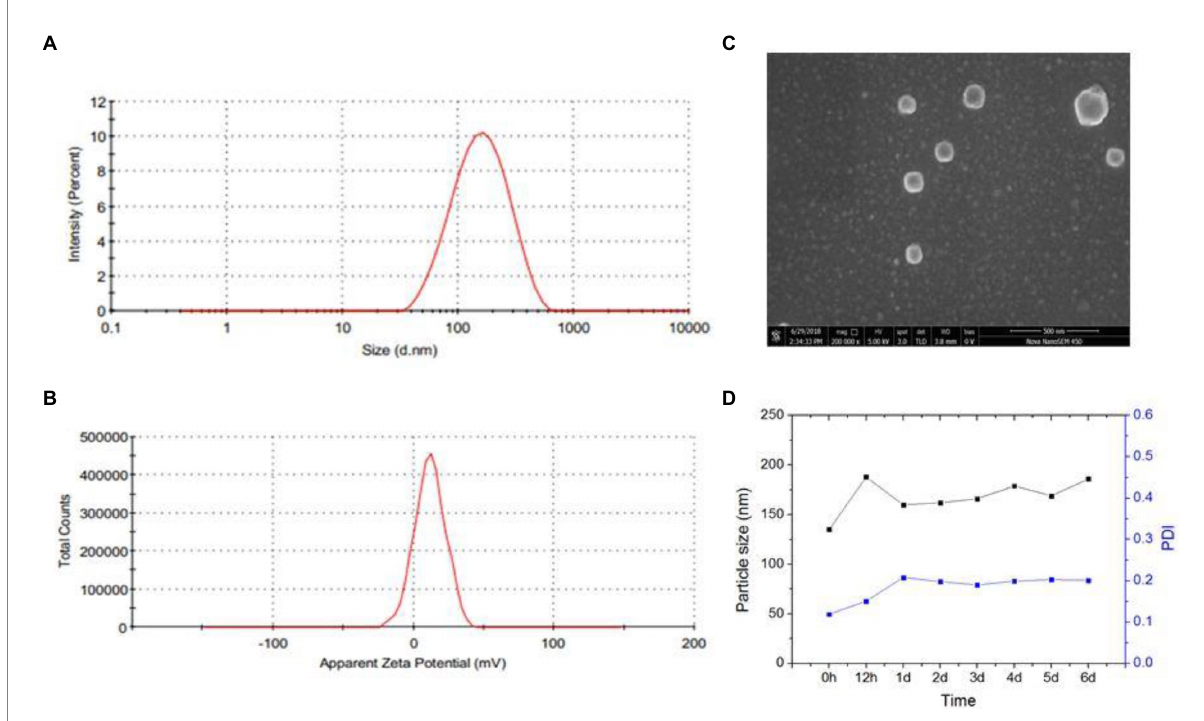
FIGURE 5 Characterization of CS-SS-LF micelles. (A) CS-SS-LF micelles were analyzed by DLS for size distributions. (B) CS-SS-LF micelles were analyzed by DLS for zeta potential. (C) SEM image of CS-SS-LF micelles. (D) Changes of diameter and PDI of CS-SS-LF micelles for 6 days at room